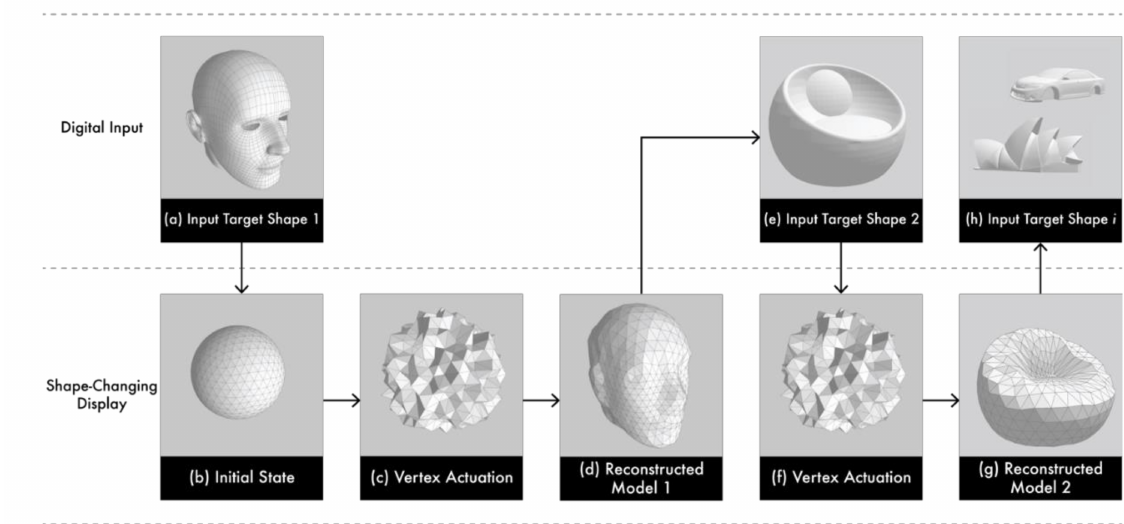
Figure 2. Example of transforming a shape by adjusting the vertex value in the icosphere model: ( a ) inputting the target shape, ( b ) setting the icosphere model, ( c ) actuating each vertex, ( d ) reconstructing it in the form of the target, and ( e – h ) iterated reconstruction of the new target